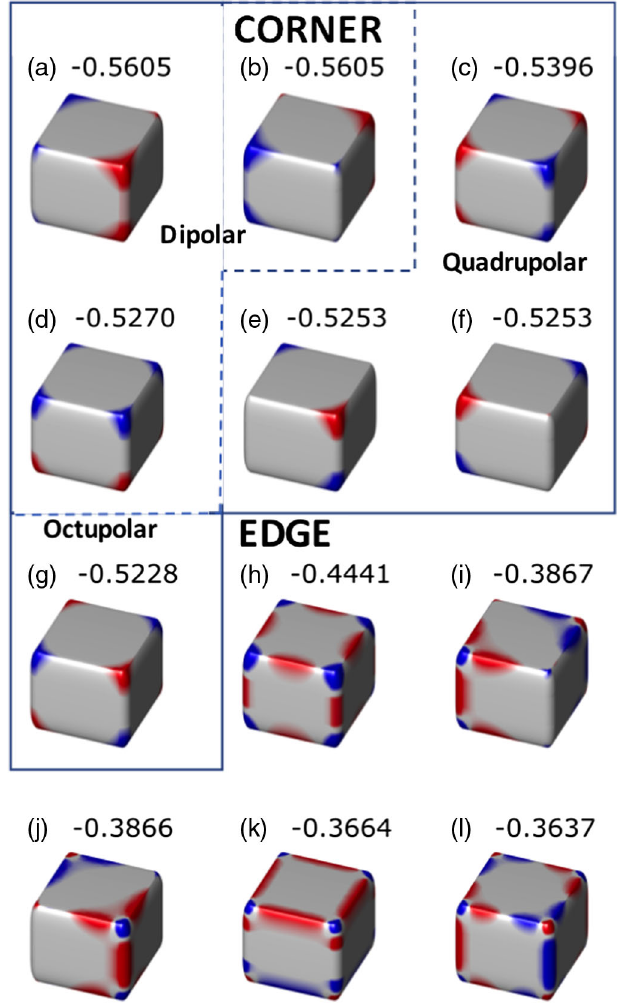
FIG. 5. Modes symmetry for a cube in the quasistatic approxi- mation. Values of λ are given on top of the corresponding i eigencharge distributions (red is minimum and blue maximum). (a) – (g) Corner modes and (h) – (l) edge modes. Corner modes have been separated with respect to their